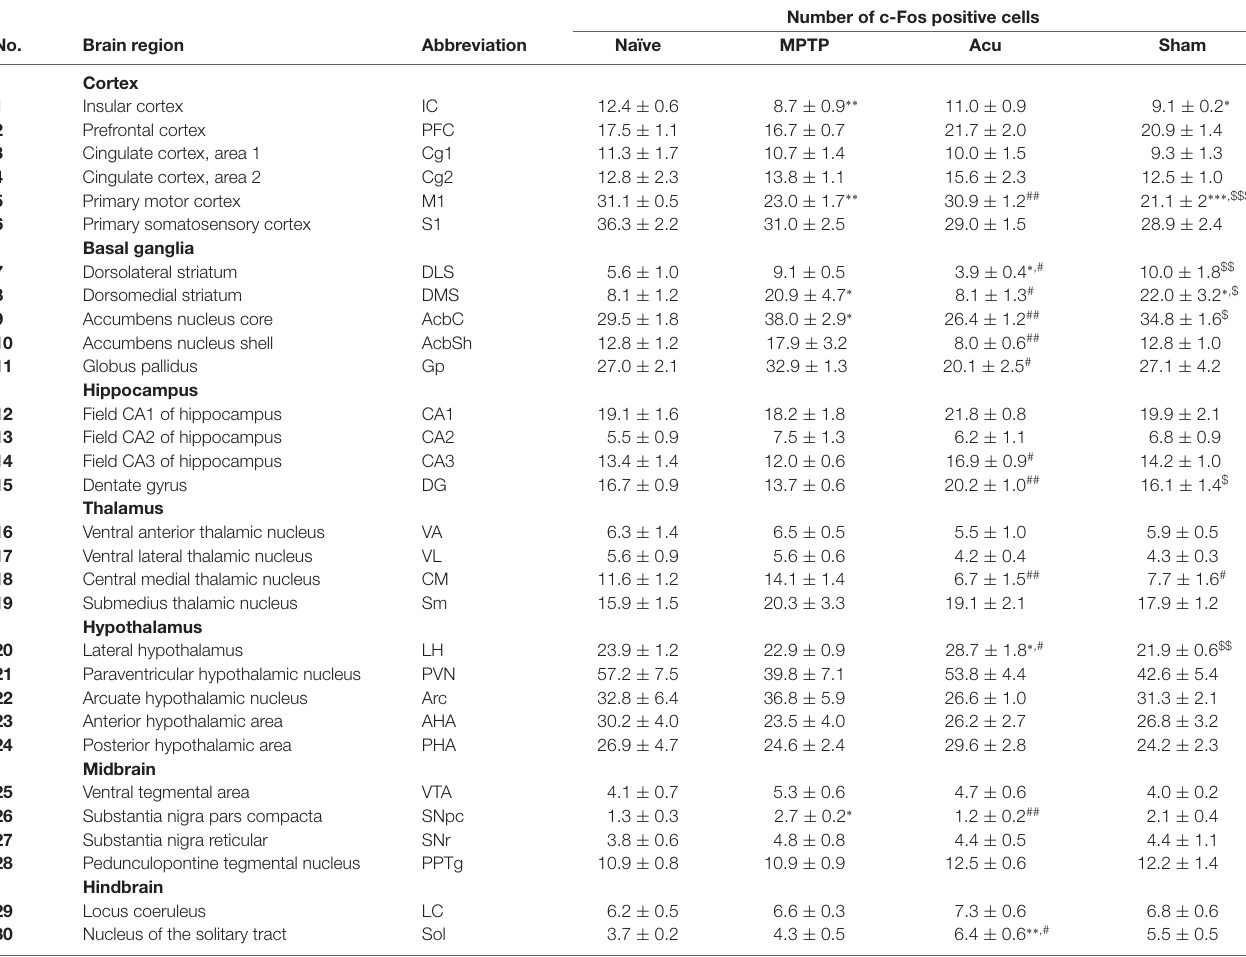
TABLE 1 | Abbreviations of 30 brain regions and the number of c-Fos-positive cells in each regions.